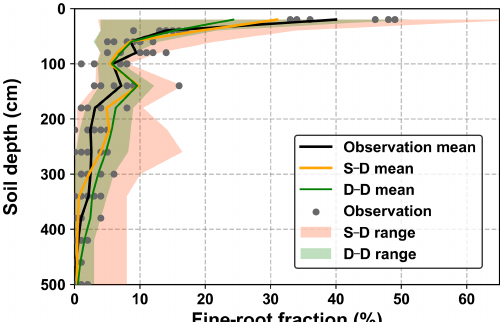
Figure 7. Comparison of the 5m profile-averaged soil water con- tent (SWC) from observations (OB) and the two root simulation ap- proaches during the calibration (2014–2016) and validation (2017– 2018) periods. The abbreviations used in the figure are as follows: S–D – static rooting depth and dynamic fine-root distribution; D–D – dynamic rooting depth and dynamic distribution of fine roots.